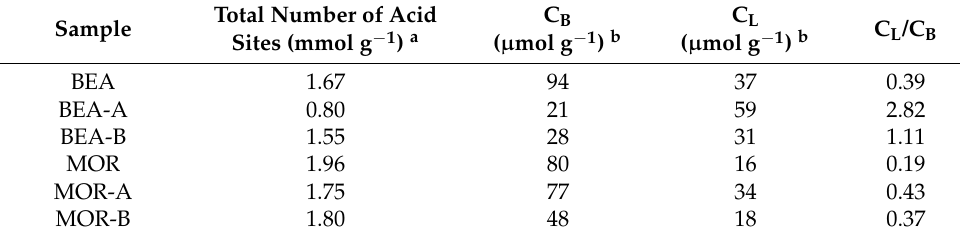
Figure 4. Acid characterization of the beta and mordenite samples using ( a , b ) TPD-NH 3 and ( c , d ) FTIR-pyridine. Table 2. Acidic properties of the beta and mordenite